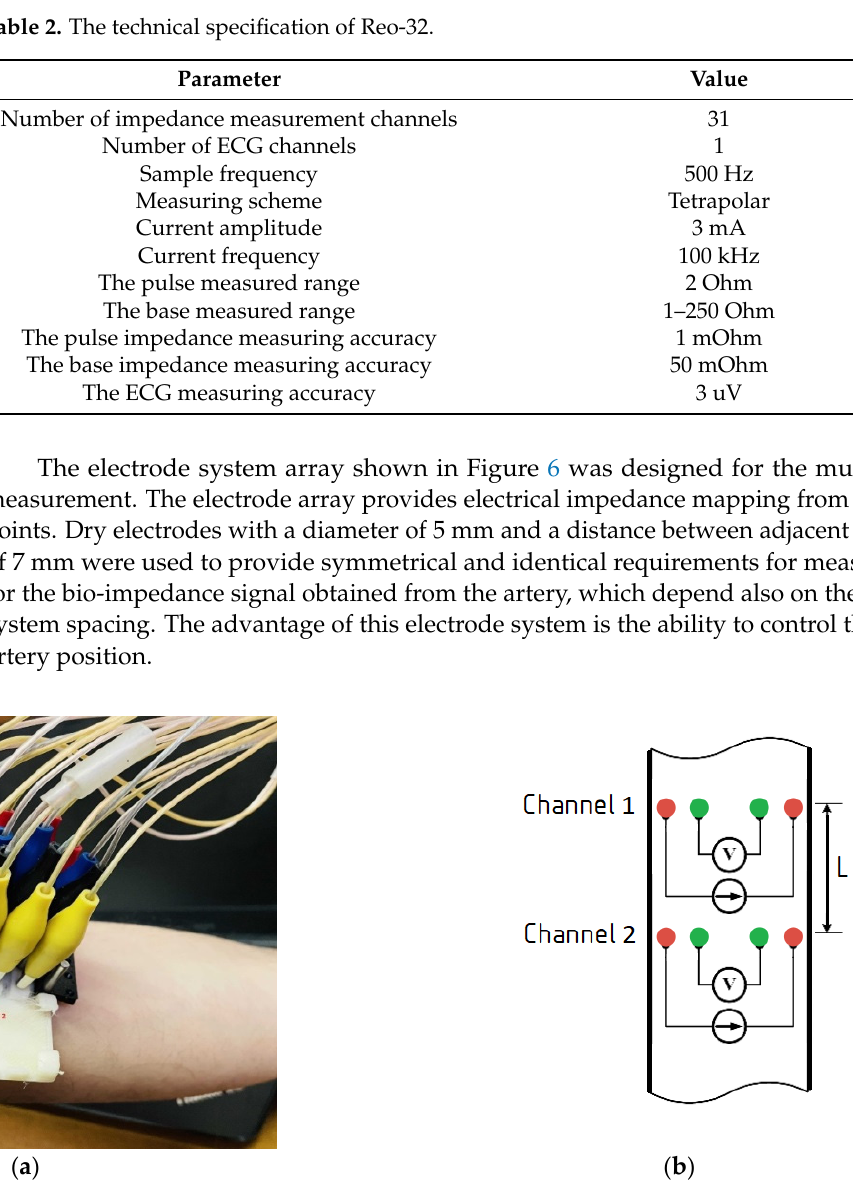
Figure 6. The electrode system prototype: ( a ) multichannel electrode system placement; ( b ) the layout scheme of the relative electrodes’ positions and channels in the region of interest.